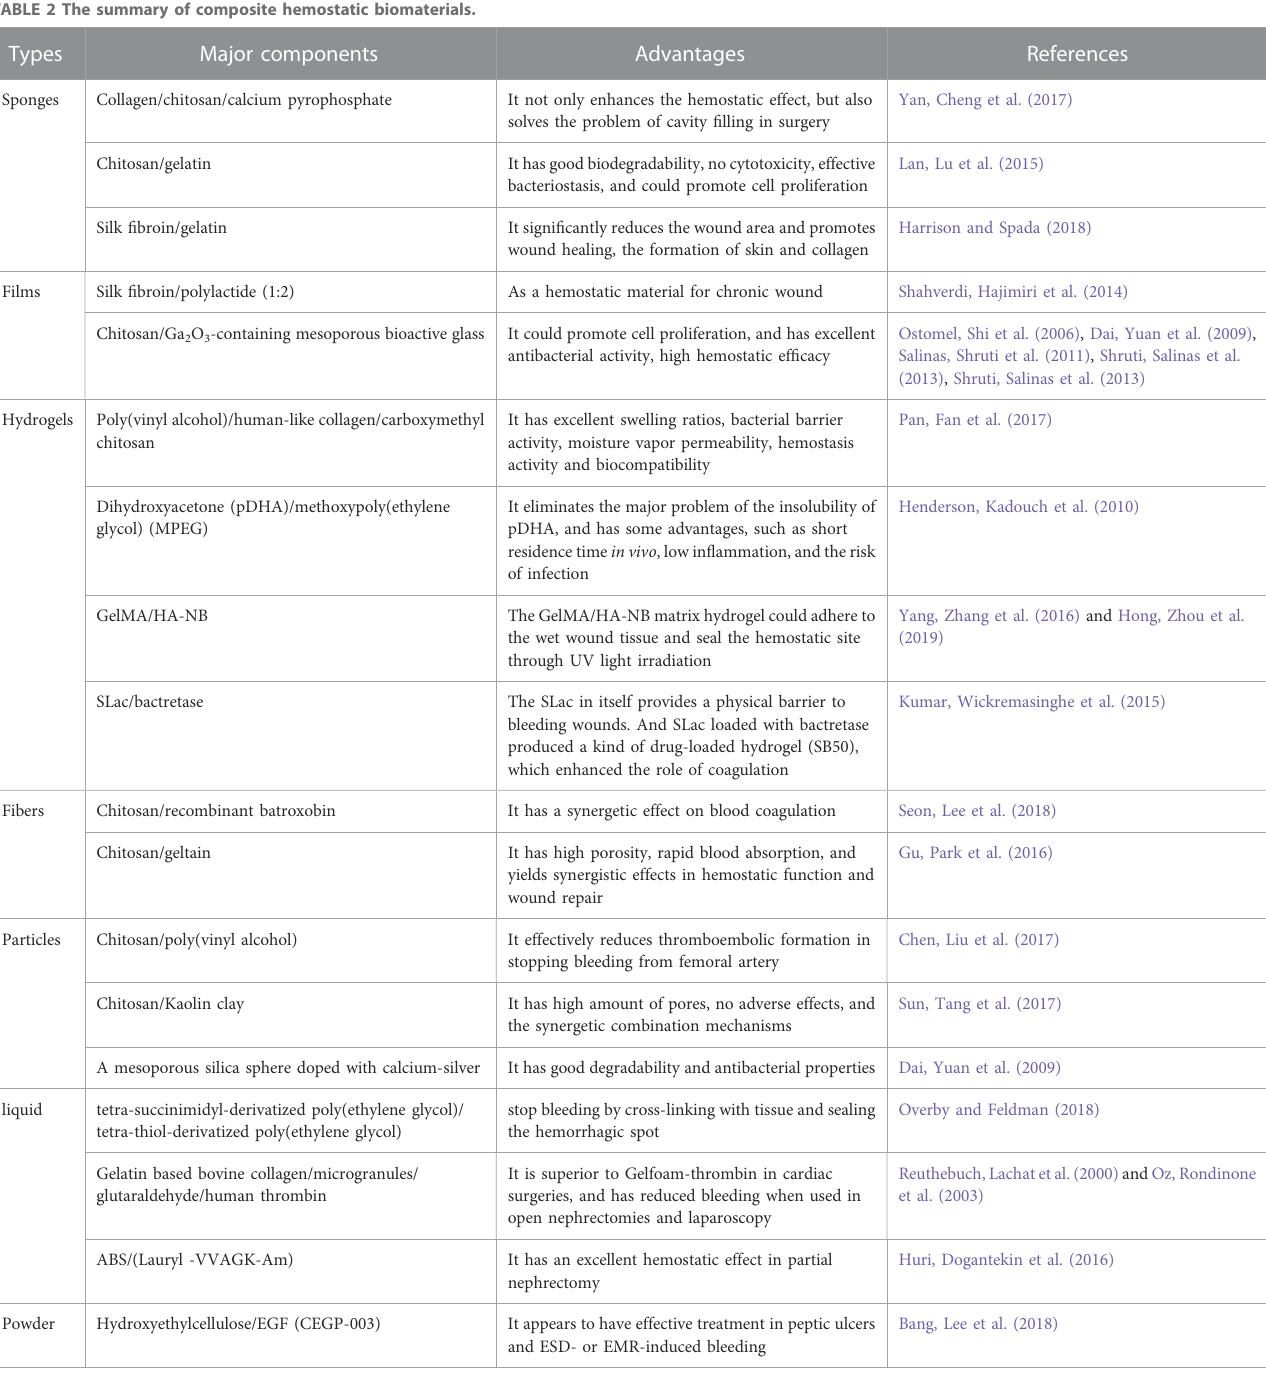
TABLE 2 The summary of composite hemostatic